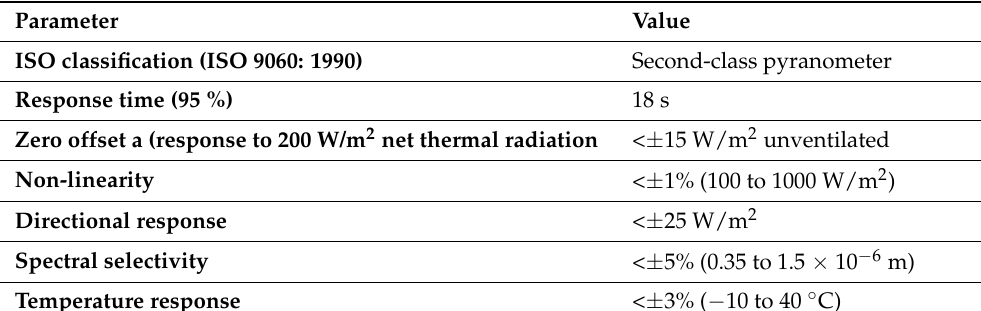
Table 3. Technical parameters of the used pyranometers.